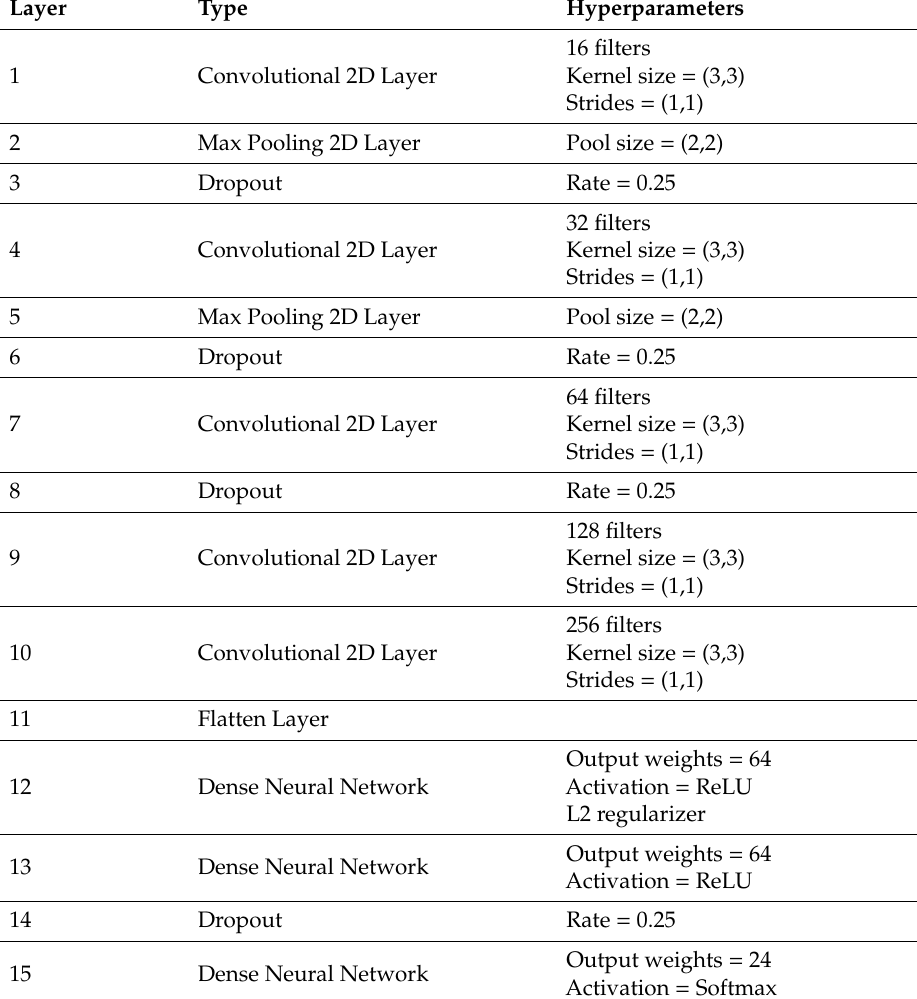
Table 1. Architecture and hyperparameters of the CNN model for speaker